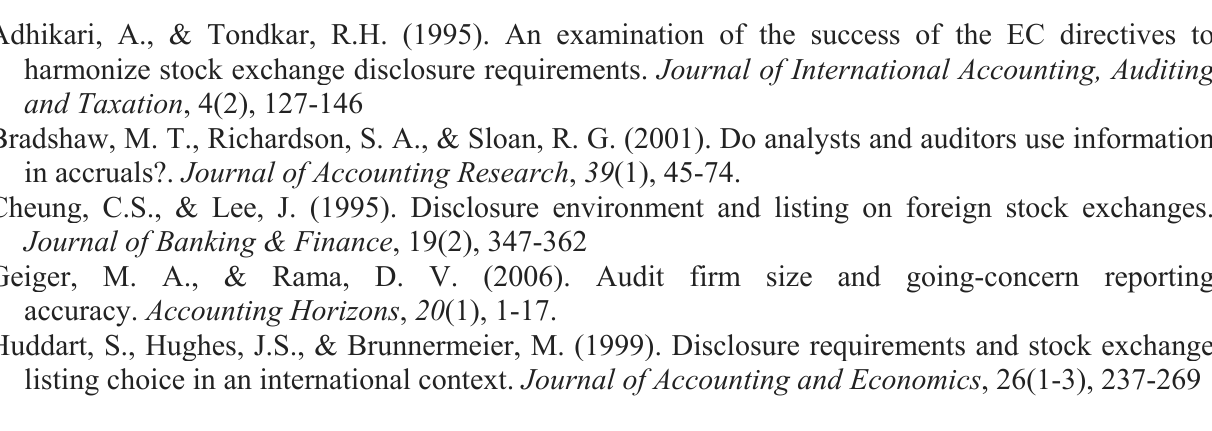
The summary of testing five hypotheses Hypothesis 2008 Liquidity influences auditing decisions for continuing requirements for firms on Tehran Stock Exchange. Profitability influences auditing decisions for continuing requirements for firms on Tehran Stock Exchange. Solvability influences auditing decisions for continuing requirements for firms on Tehran Stock Exchange. Cash flow influences auditing decisions for continuing requirements for firms on Tehran Stock Exchange. Size of audit firm influences auditing decisions